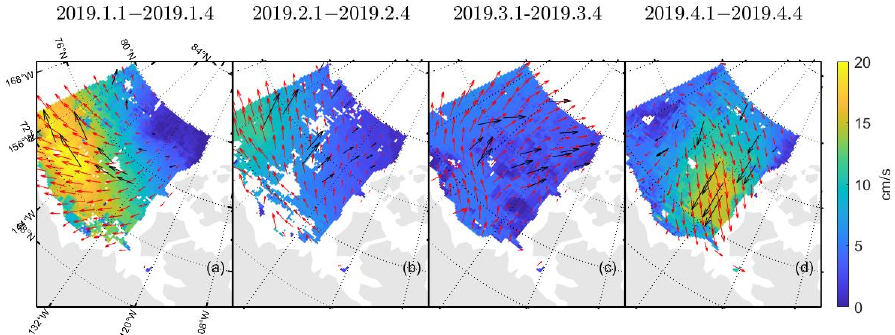
Figure 9. The sea ice motion obtained by merging different frequencies and polarizations. ( a ) is the sea ice motion on 1 January 2019, ( b ) is the sea ice motion on 1 February 2019, ( c ) is the sea ice mo ‐ tion on 1 March 2019, ( d ) is the sea ice motion on 1 April 2019.